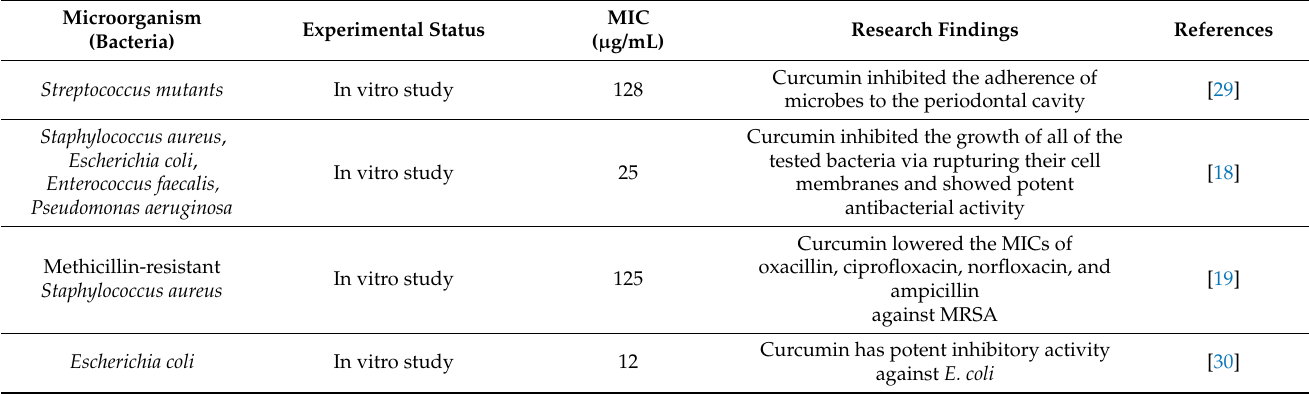
Table 1. An overview of the experimental studies on the antibacterial effects of